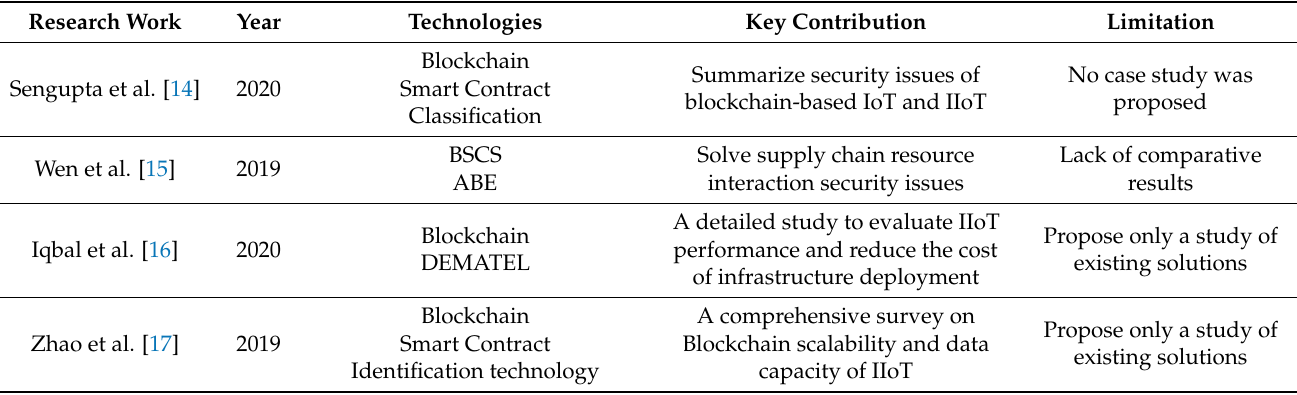
Table 1. Related Works Comparison